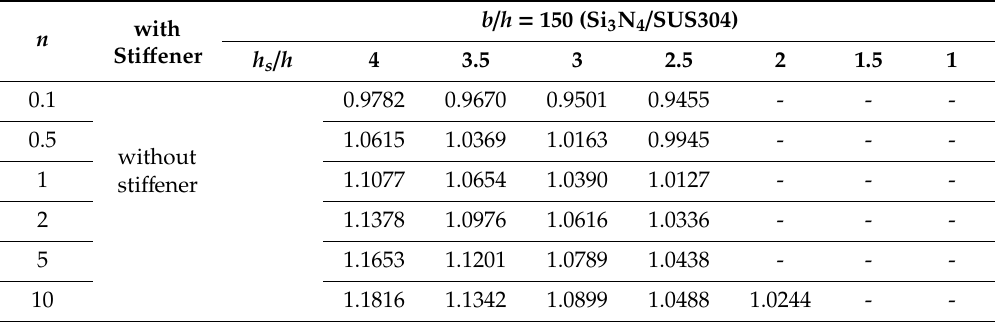
Table 8. The mass reduction between Si 3 N 4 / SUS304 plate with and without a central sti ff ener ( b / h =